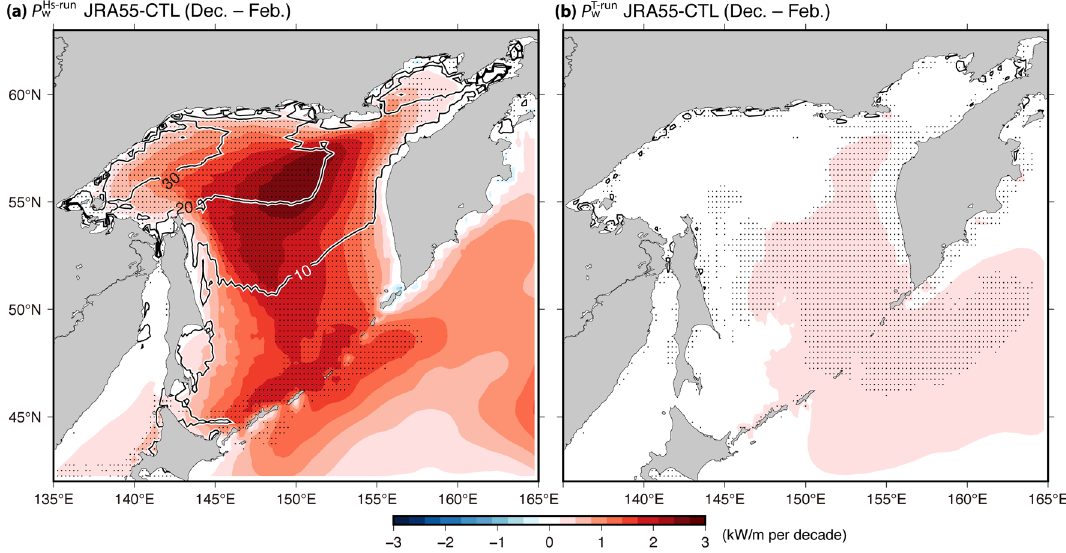
− run P T − run w and ( b ) w derived from